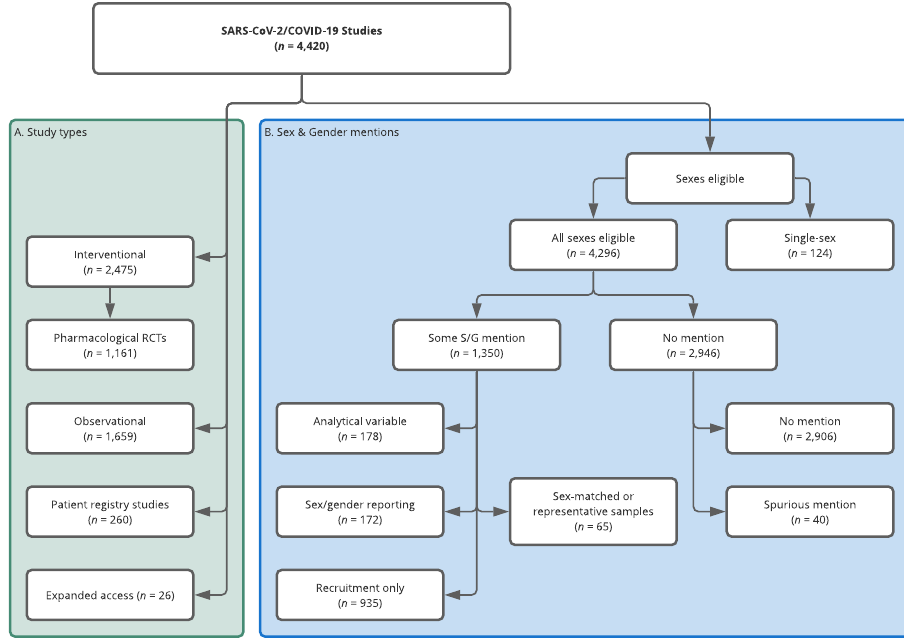
Fig. 1 Study types and allocation into sex/gender (S/G) attention groups for the COVID-19 sample. The left-hand (green) panel shows the distribution of the 4420 identi fi ed studies across study types. We created the (Pharmacological) RCT label following the procedure outlined in Methods section, the other classi fi cations are taken from ClinicalTrials.gov. The right-hand panel (blue) shows the distribution of studies across the various mutually exclusive sex/gender groups we de fi ned (see Methods section). In the ‘ Some S/G mention ’ set there is a hierarchy. The most extensive consideration was sex/ gender as an analytical variable and after that sex/gender matching/representation, followed by explicit statements of intent to record or report participant sex/gender. Finally, the ‘ Recruitment Only ’ contains those studies whose only sex/gender mention was in a recruiting context. We allocated the studies to one of the categories based on the highest category of S/G consideration. For instance, if they reported attention to S/G in analysis and recruiting, we only counted them in